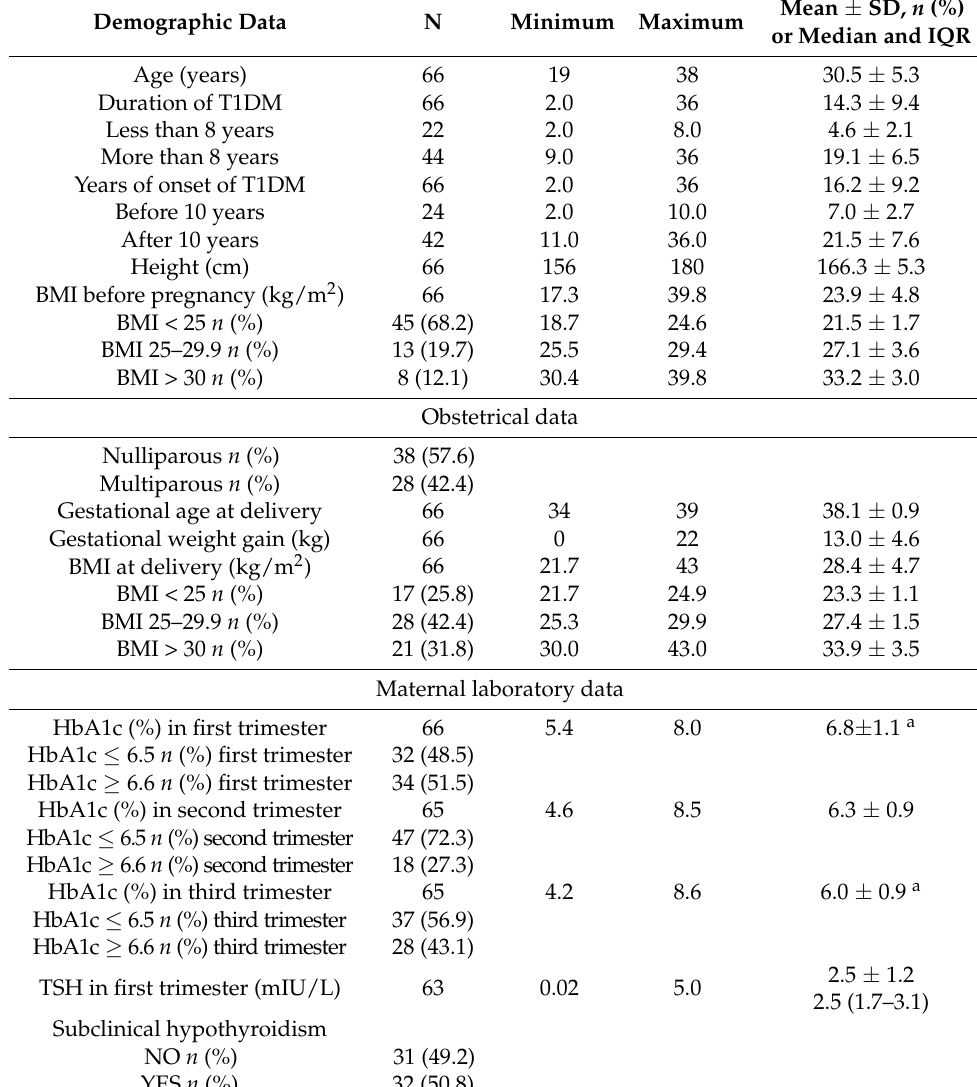
Table 1. Maternal demographic, obstetric, and laboratory